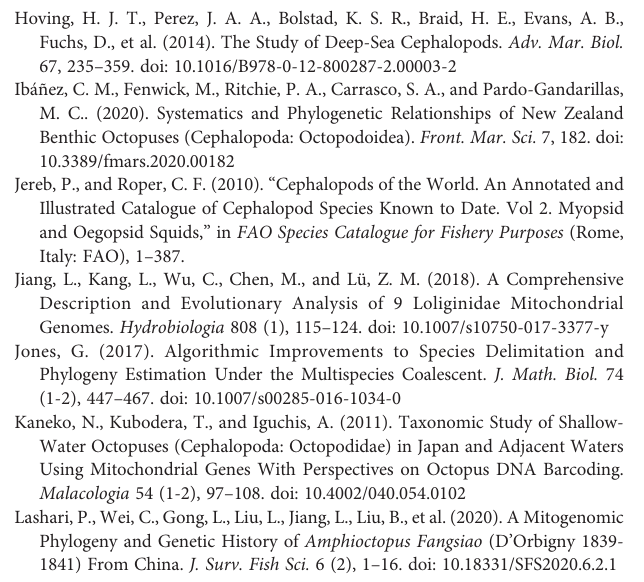
Supplementary Figure 1 | The Bayesian tree based on the cytochrome c oxidase subunit I sequences. The number in each node represents the posterior probability